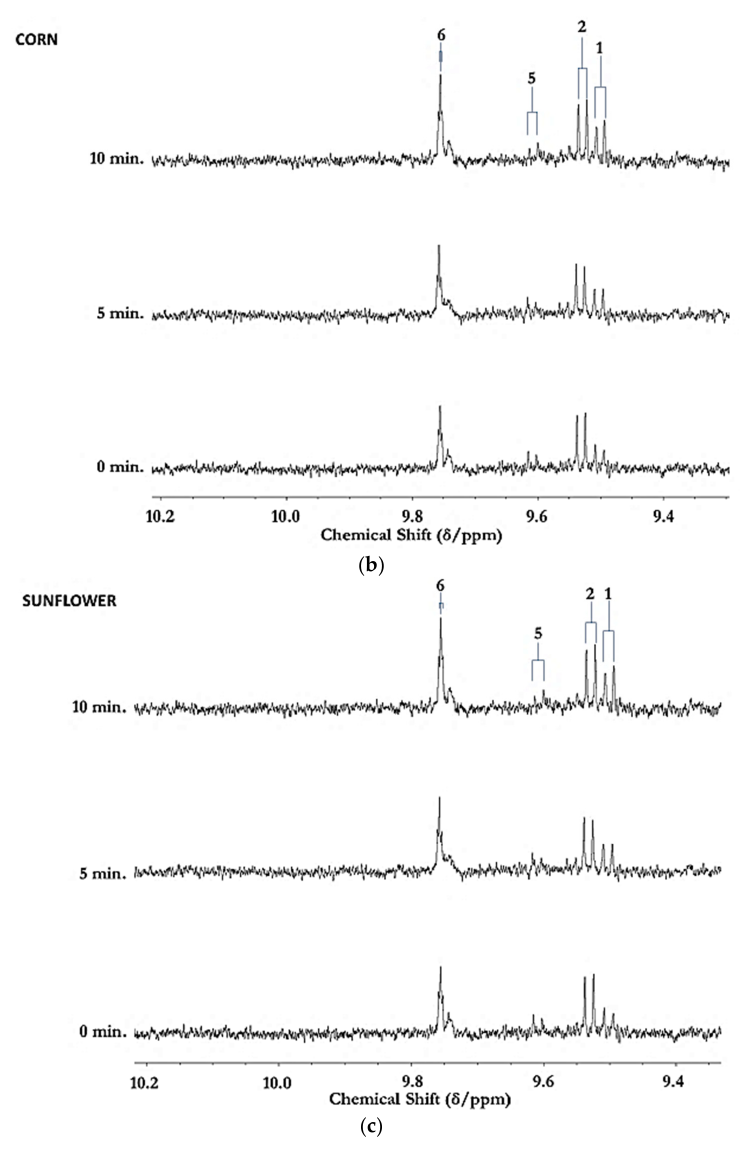
Figure 1. ( a ) Expanded aldehydic-CHO proton (9.35–10.20 ppm) region of 600 MHz 1 H NMR spectra of a typical canola oil product exposed to thermal stressing episodes at 180 ◦ C for periods of 0–90 min according to our LSSFEs (samples were collected for 1 H NMR analysis at the 0 (unheated), 5, 10, 20, 30, 60 and 90 min time-points). ( b , c ), Corresponding 400 MHz 1 H NMR spectral regions of commercially available UK brands of corn and sunflower oils, respectively, heated under the same conditions for only 0, 5 and 10 min. All resonances visible are doublets ( J = 7.63 Hz for trans -2-alkenals), with the exception of the n -alkanal one which is a triplet ( J = 1.83 Hz). Assignments for these signals were confirmed via the acquisition of corresponding one- and two-dimensional correlation (COSY) and total correlation (TOCSY) spectra for each heated oil as described in [12,19,20]. Detectable aldehyde levels for the unheated (time-point = 0 min) corn and sunflower oil samples are notable. Abbreviations: 1, trans -2-alkenals (doublet); 2, alka-( trans , trans) -2,4-dienals (doublet); 3,4,5-Epoxy- trans -2-alkenals (doublet); 4,4-hydroxy-/4-hydroperoxy- trans -2-alkenals (overlapping doublets); 5, alka-( cis , trans )-2,4- dienals (doublet); 6, higher homologue n -alkanals (triplet); 7, low-molecular-mass n -alkanals (triplet) such as ethanal and propanal, which predominantly arise from the peroxidation of linolenoylglycerol substrates available in soybean oil (up to 9.5% ( w / w )); ethanal is also generated from the thermal degradation of deca-2,4-dienals [13]); 8, cis -2-alkenals (doublet); 9, unidentified aldehyde, presumably a substituted cis -2-alkenal